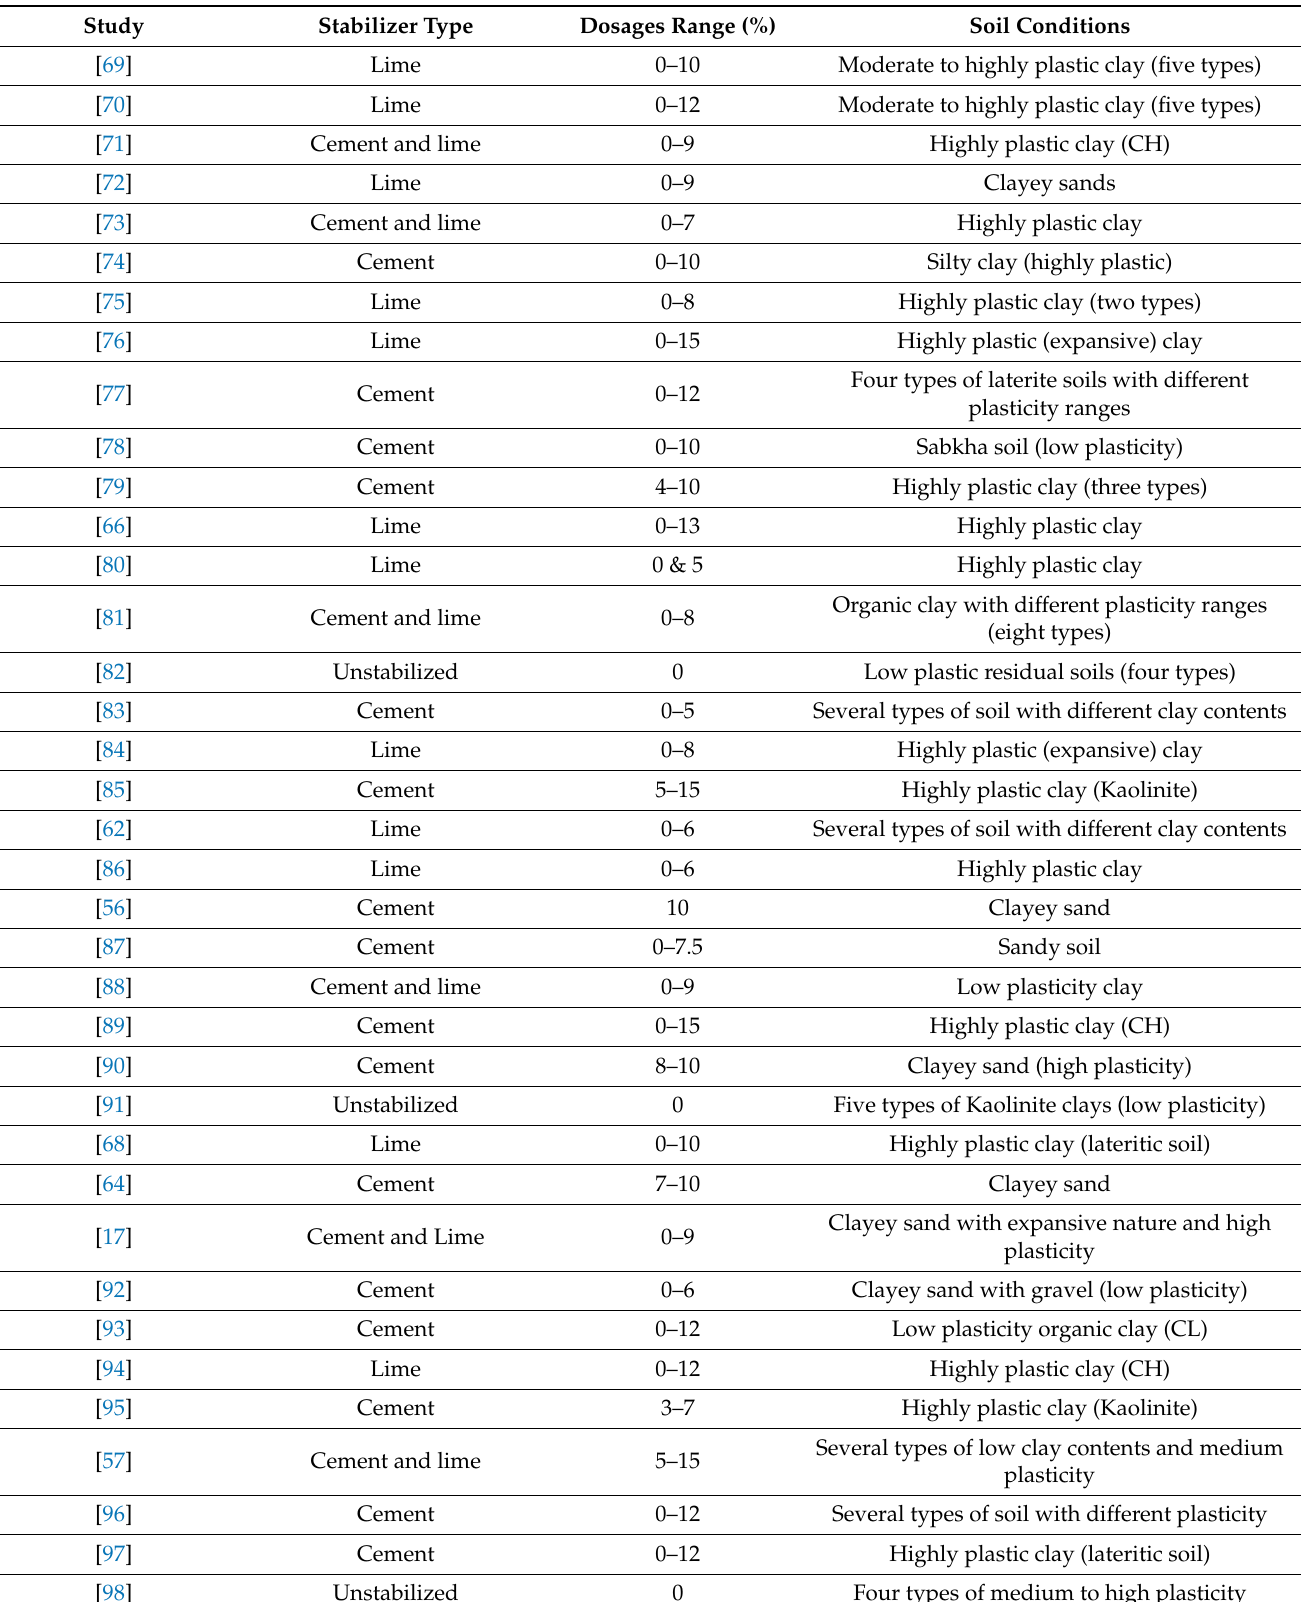
Table 4. Summary of the data